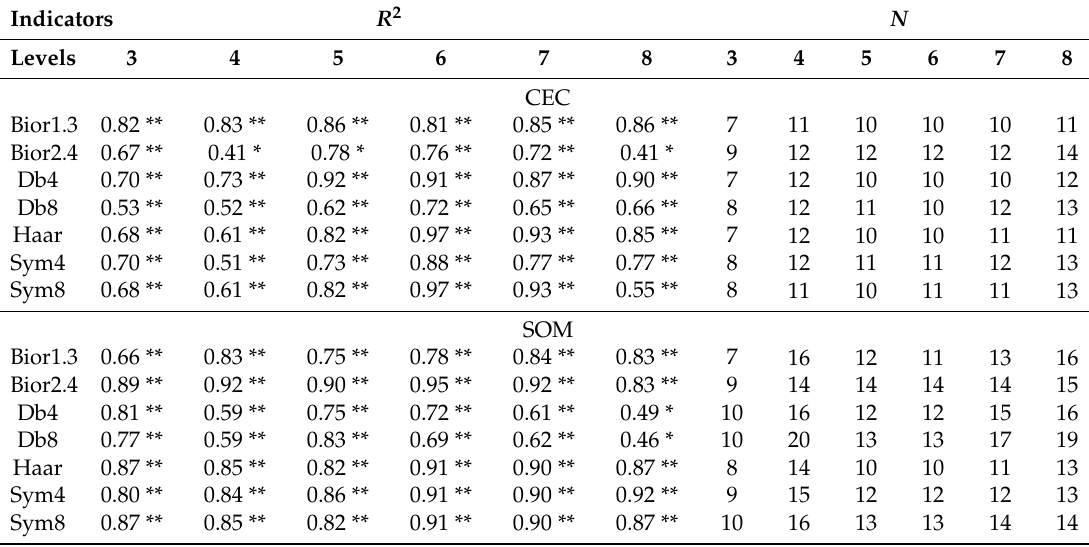
Table 5. Coefficient of determination ( R 2 ) values and number of variables ( N ) used in discrete wavelet transform with partial least-squares (DWT–PLS) models for CEC and SOM in calibration set. Indicators R 2 N